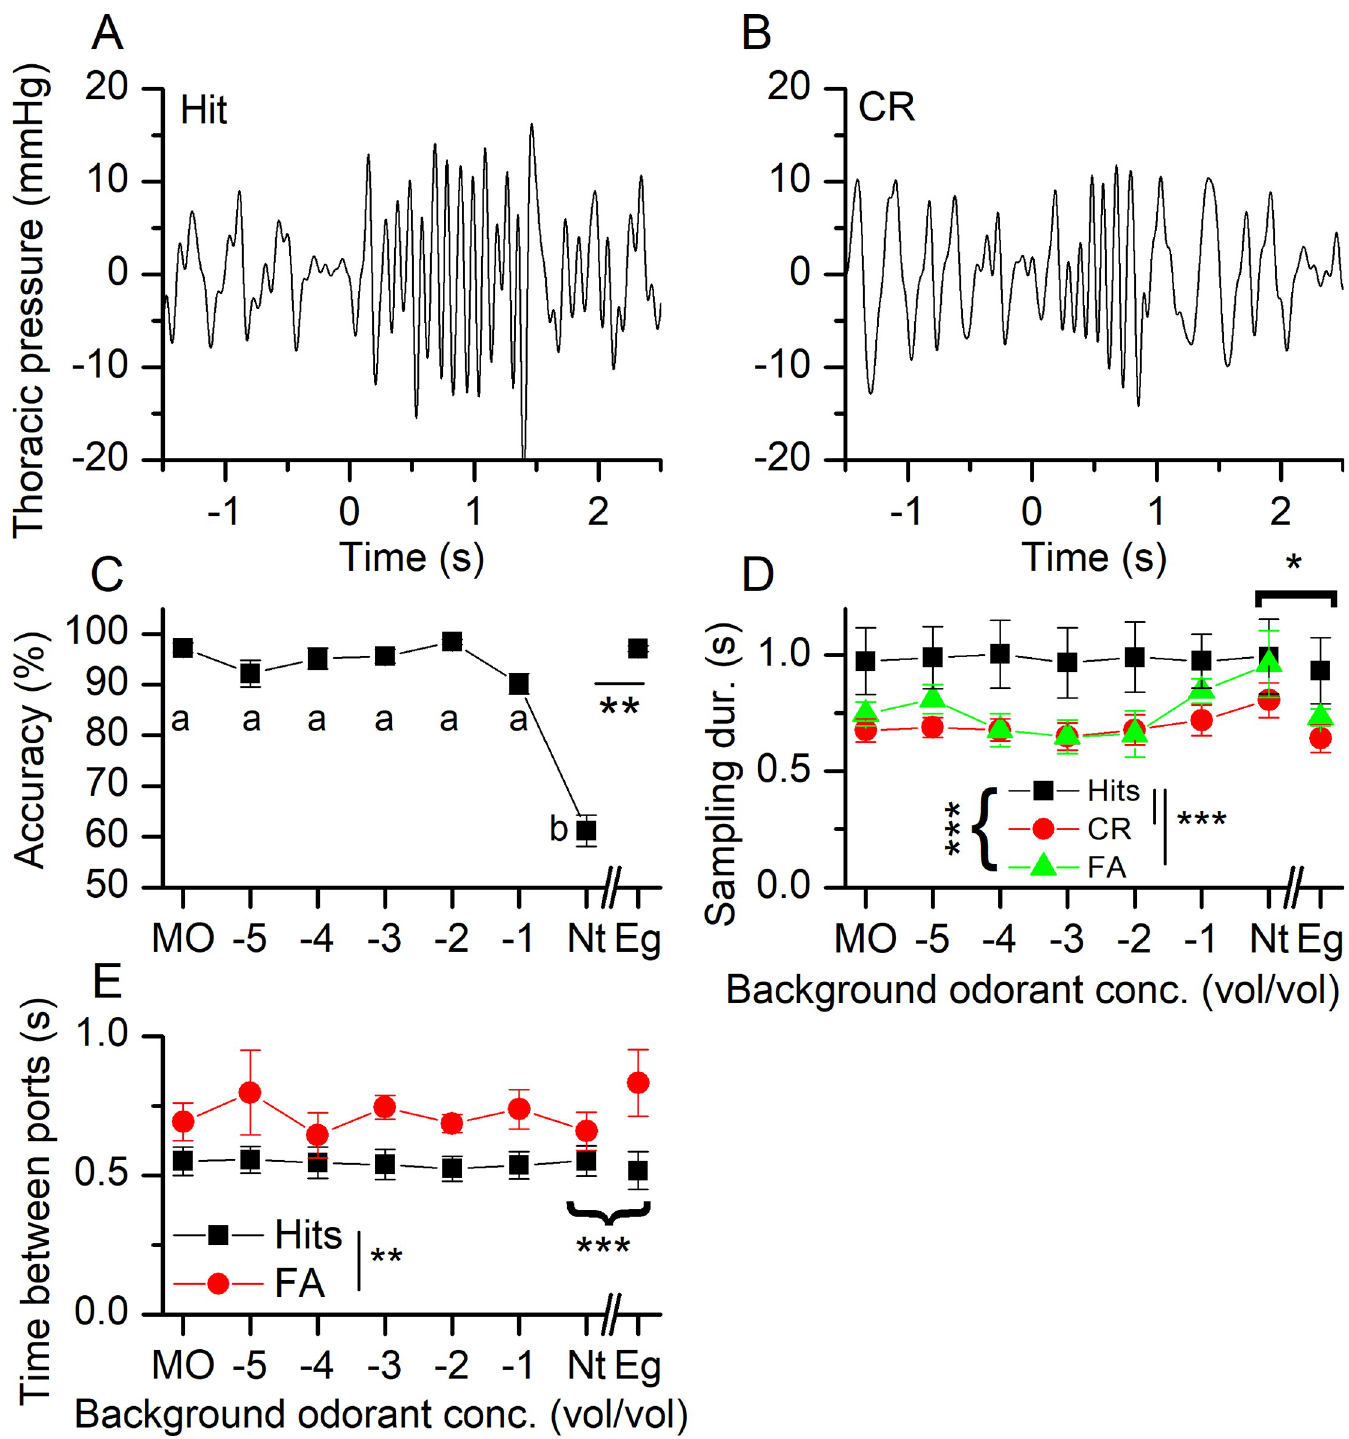
Fig 5. The effect of background odorant concentration on olfactory acuity. Mice were tested to distinguish 10 − 4 propanol from the carrier mineral oil (MO) in the presence of increasing background concentrations of propanol up to undiluted (neat, Nt) propanol and also undiluted eugenol (Eg). The breathing pattern during ( A ) Hit and ( B ) a correct rejection (CR) trial when exposed to 10 − 4 propanol concentration in the odor port in the background of MO. Time 0 is the onset of the nose poke into the odor port. The odorant was delivered at 0.5 s. C Response accuracy, same letters indicate the absence of significance, repeated measures ANOVA (F(6,18) = 45.2 p = 0.001) followed by post-hoc Tukey. Neat (Nt) propanol and eugenol (Eg) were significantly different (paired t-test, p = 0.0018). D The odorant sampling duration for Hits, CR and FA. Mixed Model ANOVA revealed mouse behavior as main effects with F = 1.6, p = 1.86e -09 . Hits were different from CRs and FAs (Post-hoc with